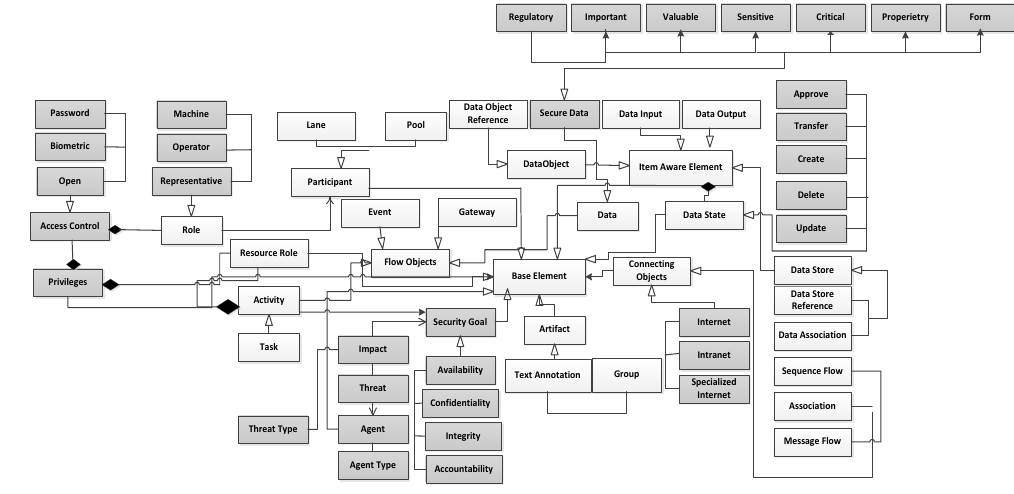
Figure 4. Proposed BPMN meta model extension using security objects.